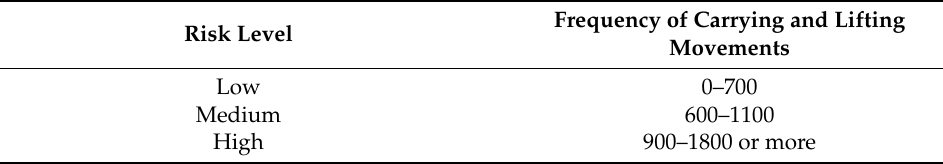
Table 3. Assignment of risk level for the frequency of